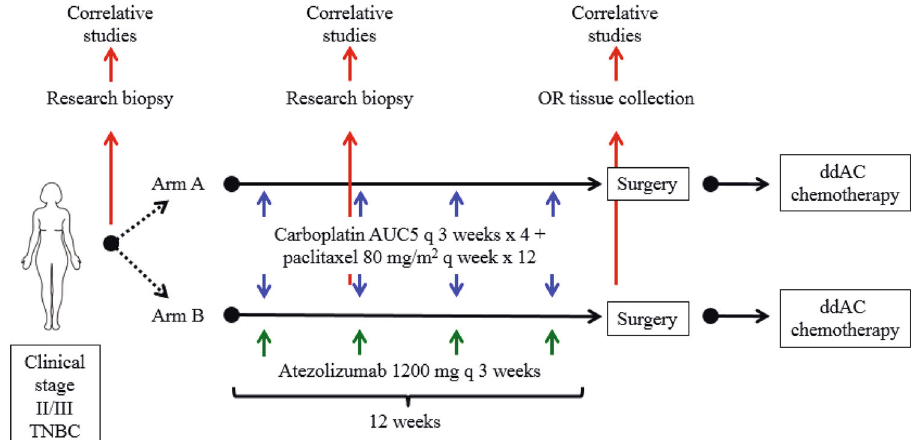
Fig. 6 Clinical trial schema outlining treatment arm, randomization, collection of biopsies, and adjuvant treatment. AUC area under the curve, dd dose